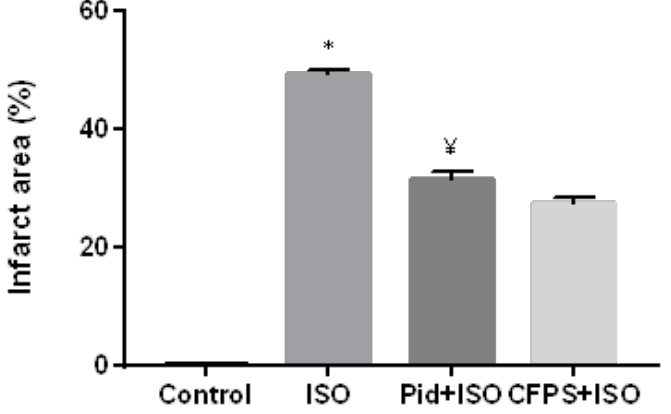
Figure 7. Effect of CFPS on infarct area in control and experimental treated rats as determined by TTC. Values are expressed as mean ± SD of eight rats in each group. * p < 0.05: controls vs. ISO. ¥ p < 0.05: CFPS + ISO or Pid + ISO vs. ISO.